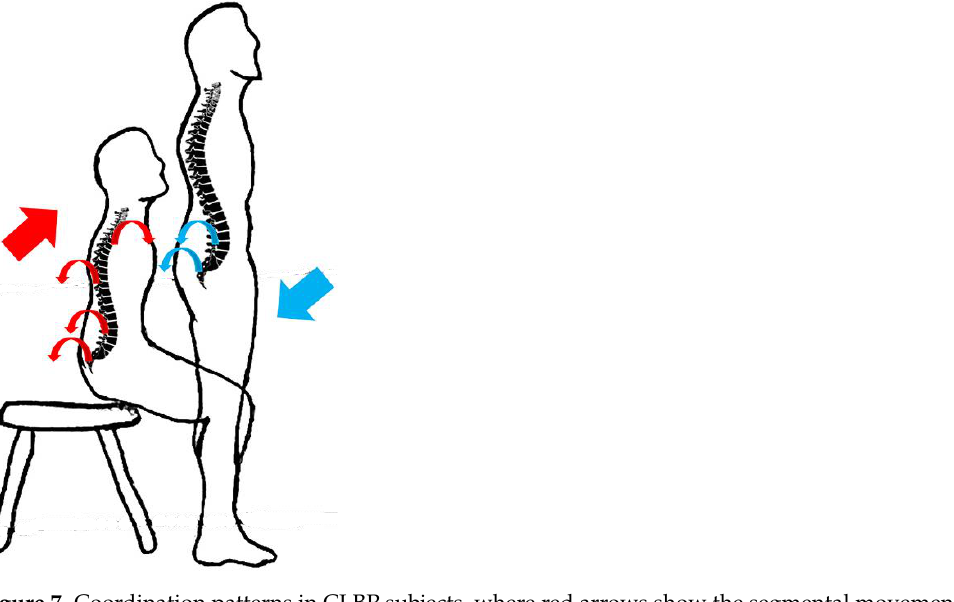
Figure 7. Coordination patterns in CLBP subjects, where red arrows show the segmental movement during sit-to-stand, and the blue arrows show those during